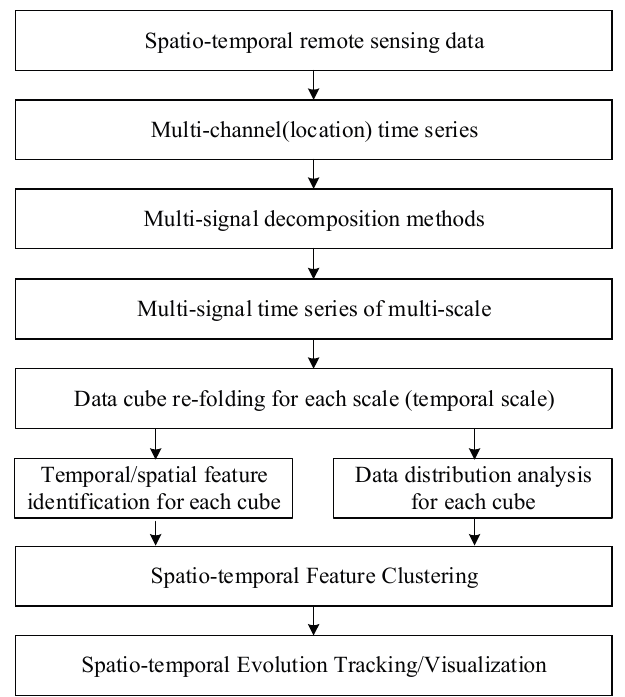
Figure 1. The overall framework of the exploratory multi-scale spatio-temporal feature